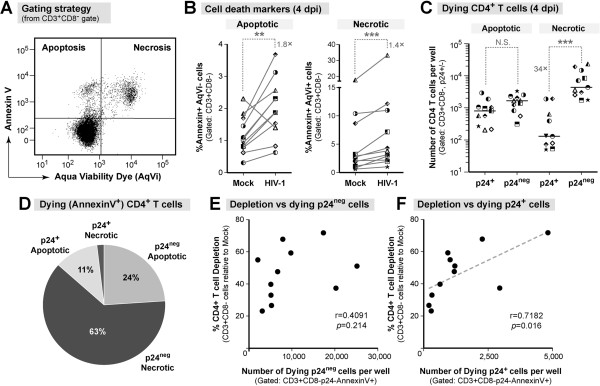
HIV-1 infection increases cell death markers in LP CD4+ T cells. (A) Representative flow plot of AnnexinV/AqVi staining. Note that in contrast to Figure 1B, there was no AqVi exclusion gate prior to identifying lymphocytes from the FSC/SSC profile. Cells expressing AnnexinV were considered committed to dying. (B) The percentage of CD3+CD8- T cells expressing either an apoptotic (left) or necrotic (right) profiles were compared between mock and HIV-1 infected conditions. Each symbol is a unique donor. The fold differences in median expression are shown. Significance was determined using the Wilcoxon matched-pairs signed rank test. (C) The numbers of p24+ and p24neg cells per well with an apoptotic or necrotic phenotype were calculated. Each symbol represents a unique donor. The median values are shown and the fold-change is indicated for significant differences. Significance was determined using the Wilcoxon matched-pairs signed rank test. (D) Apoptotic versus necrotic p24+ and p24neg cells as a percentage of the total number of LP CD3+CD8- T cells committed to death (n = 11). (E-F) Spearman rank correlation analysis between the number of AnnexinV+ (E) p24neg and (F) p24+ cells 4 dpi versus the 6 dpi depletion levels. The best-fit lines, Spearman r and p values are indicated. **, p = 0.009; ***, p = 0.001.